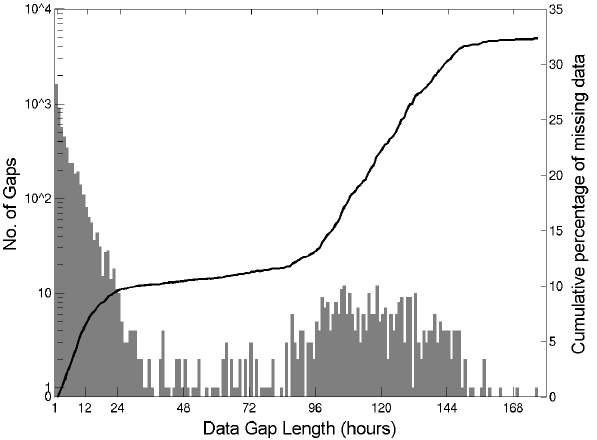
Fig. 1. Frequency of occurrence of data gaps, and the percentage of Figure 1 data lost from a notional ideal continuous data set for the OMNI 2 data after 1 January 1974. The grey histogram is the frequency at which data gaps of a particular length occur, while the solid black line is the cumulative percentage of missing data that the data gaps represent; for example data gaps of length less than 24h represent approximately 10% loss from a notional continuous data set and data gaps of less than 176h (i.e. all data gaps) represent a 33% loss.